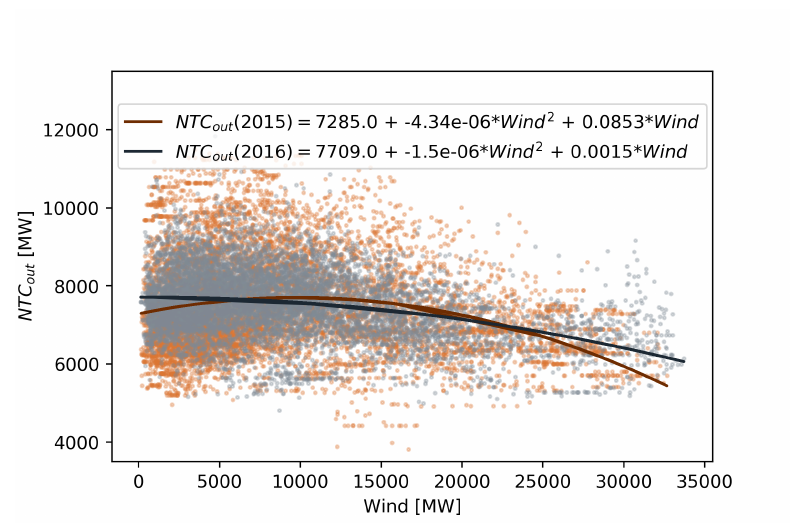
Figure 9. Relation between available export net transfer capacity (2015 and 2016) and wind generation for Germany.